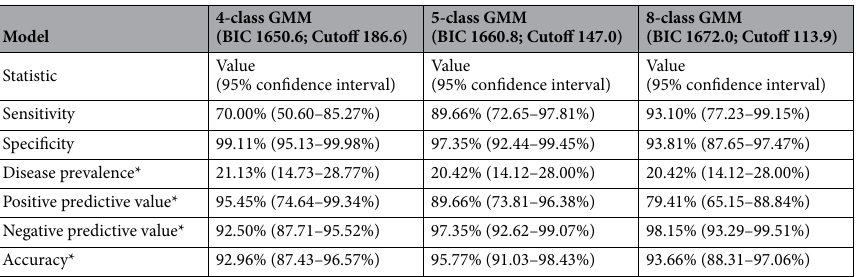
Table 2. Diagnostic performance of g3mclass solutions for ERBB2 mRNA test in IBC. *These values are dependent on HER2+ disease prevalence.